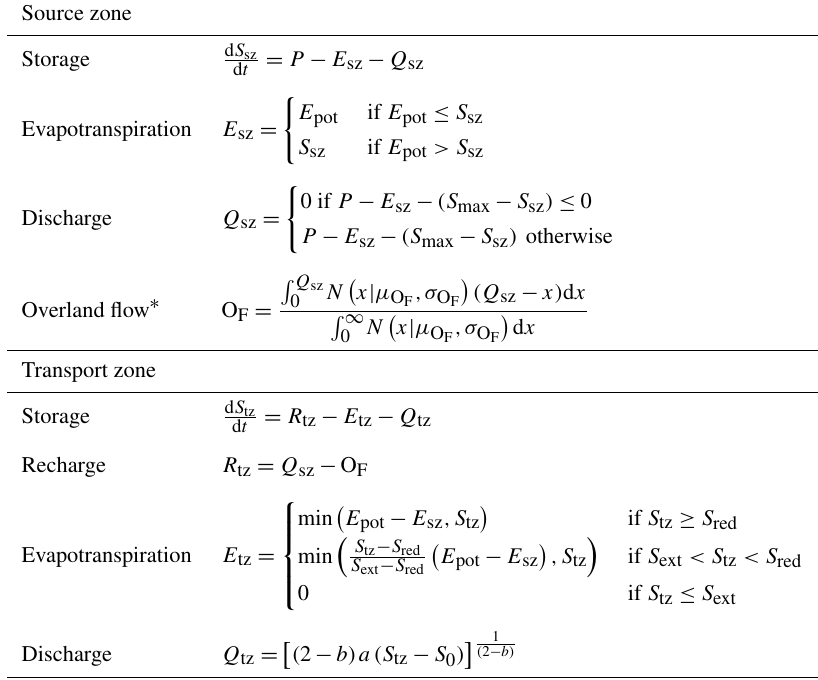
Table 1. Equations of the hydrological model. See also the explanation of parameters in Table